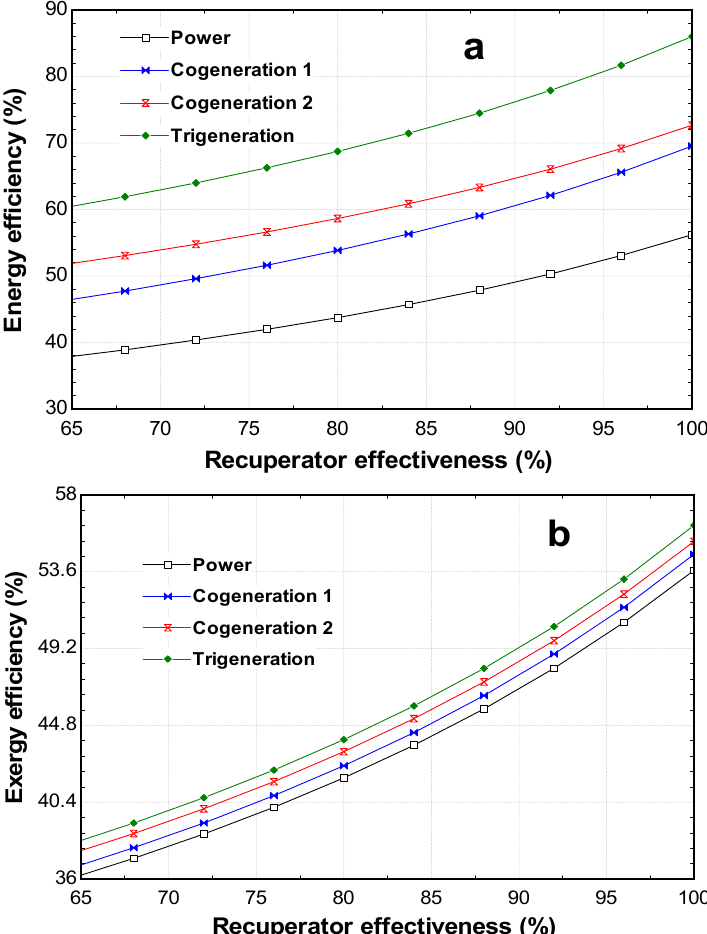
Figure 10. Effect of the recuperator effectiveness on the ( a ) energy and ( b ) exergy performance of the sub-systems and the multigeneration system.